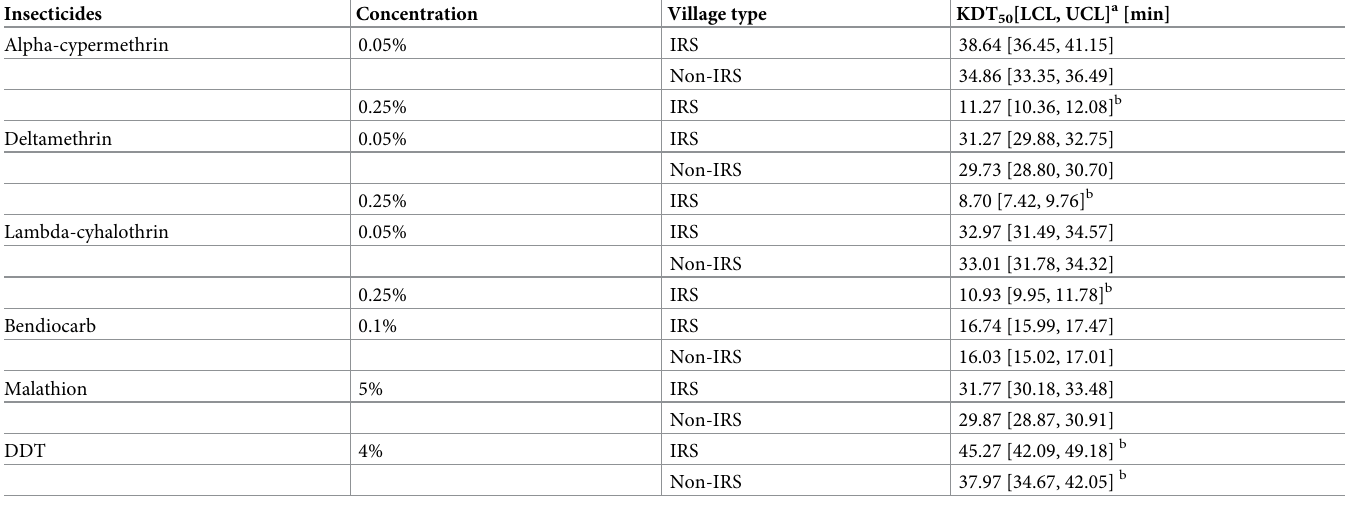
Table 2. Estimated 50% knockdown times of wild populations of P . argentipes sand flies exposed to various insecticide papers impregnated at the 1 × and the 5 × dis- criminating concentrations in the IRS and the non-IRS villages. Insecticides